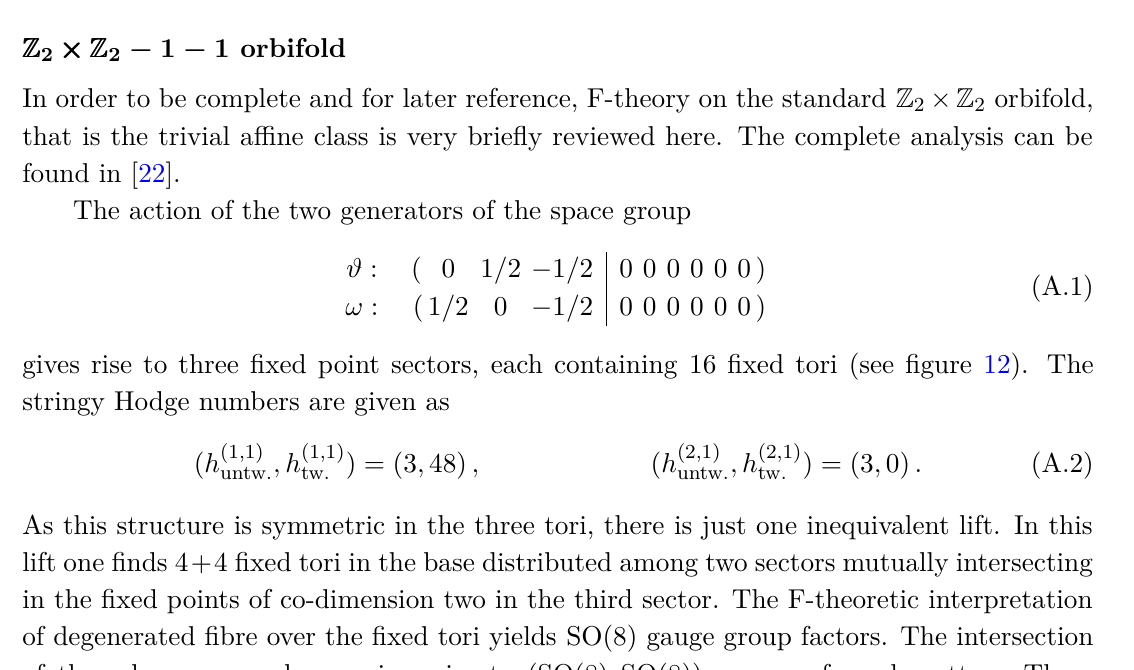
ZZZ ××× ZZZ − 1 − 1 2 2